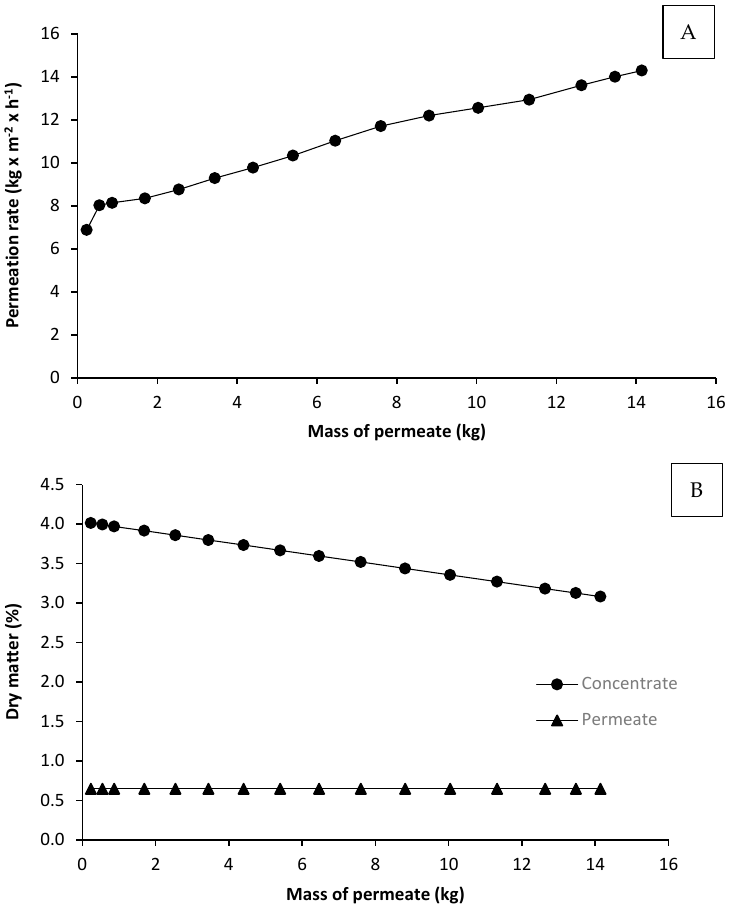
Figure 4. Permeation rate during diafiltration ( A ), and dry matter of the concentrate and permeate ( B ), as a function of the mass of the permeate. Diafiltration was carried out at constant mass of the concentrate (9.72 kg).